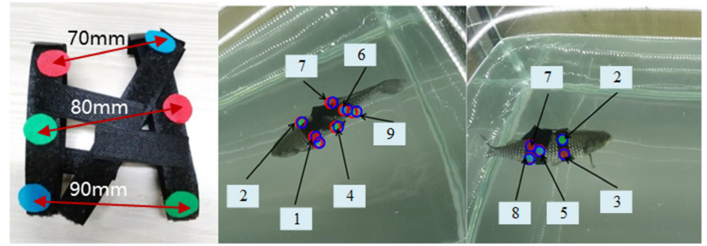
Figure 17. Captured by camera 1 ( left ) and 5 ( right ).